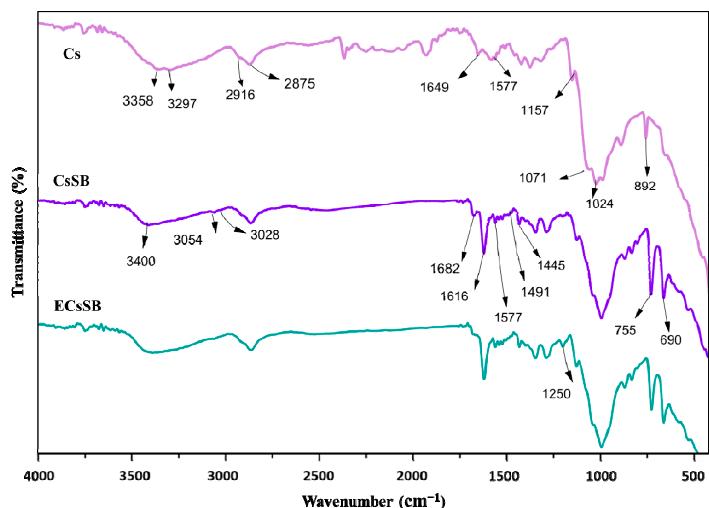
Figure 1. FTIR spectra of Cs, CsSB, and ECsSB. Polymers 2023 , 15 , x FOR PEER REVIEW